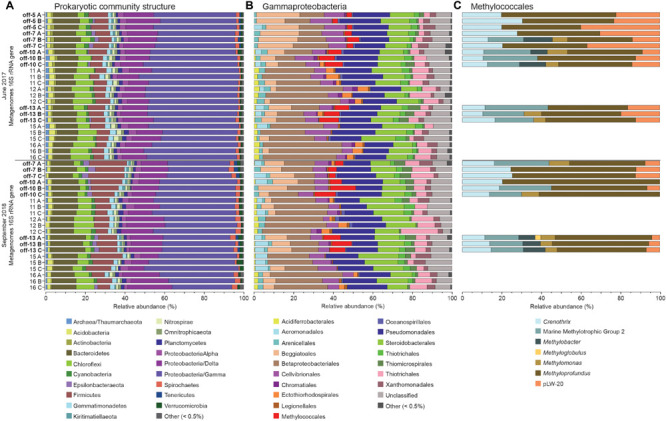
The stacked bars show relative abundance (x-axis%) of metagenome extracted 16S rRNA gene sequences: (A) prokaryotic phyla and Proteobacteria classes, (B) Gammaproteobacteria orders, and (C) Methylococcales genera (only detected in offshore stations). For (A,B) the dataset was delimited to taxonomic groups >0.5% (average of all samples). The y-axis shows the sampling year, and station names and replicate samples indicated by letters A, B, and C. Offshore stations are indicated on the y-axis with the label “off”.